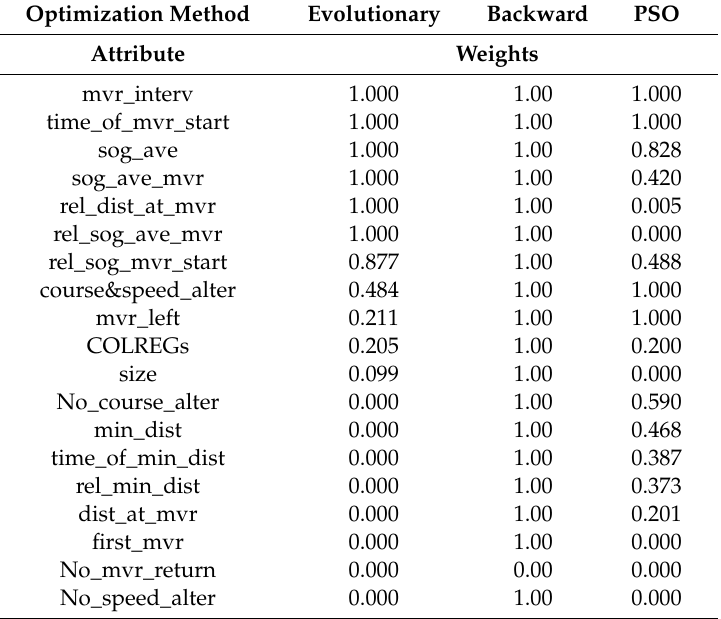
Table 3. Attribute weights after